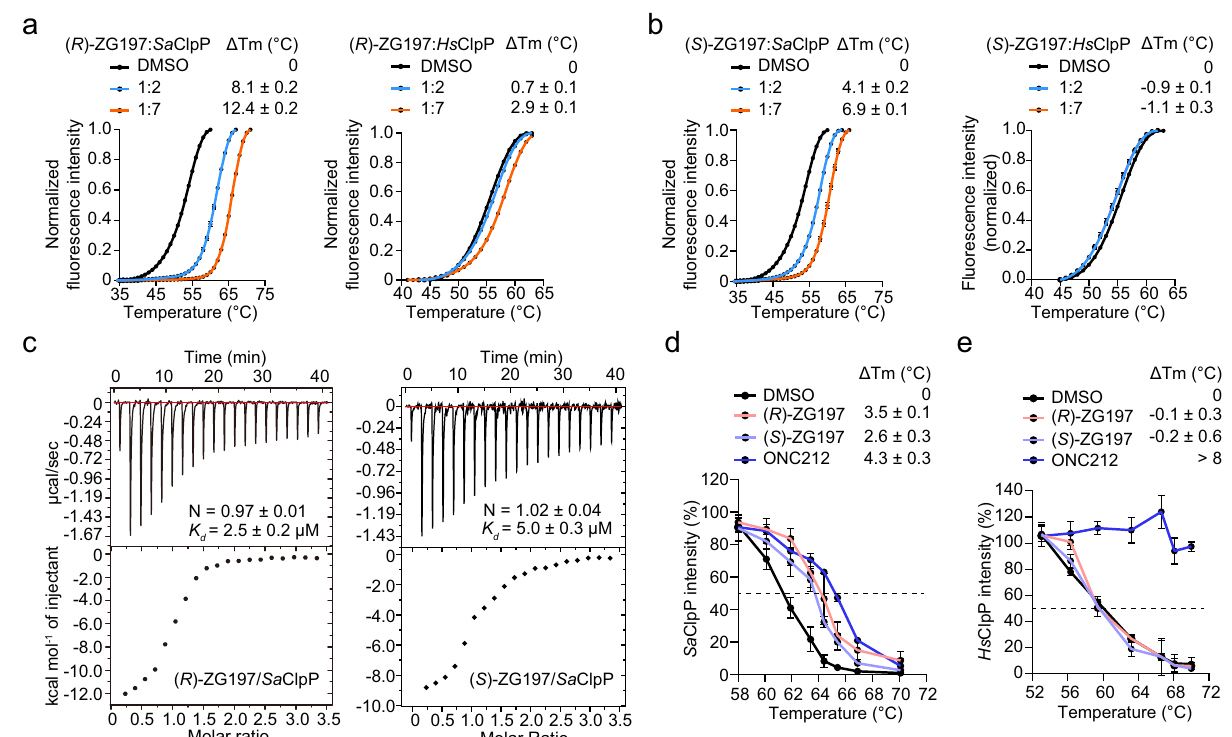
Fig. 3 | Investigation of the interaction between species-selective activators and Sa ClpP. Effect of ( R )- ( a ) and ( S )-ZG197 ( b ) on the thermal stability of Sa ClpP and Hs ClpPinDSFassay,respectively.T m ,meltingtemperature. c Determinationof ( R )-and( S )-ZG197bindingto Sa ClpPbyITCtitration.Thedissociationconstant( K d ) and stoichiometry factor (N) are indicated. Effect of activators on the thermal stabilityofthecellular Sa ClpP( d )and Hs ClpP( e ),respectively.The S.aureus 8325-4